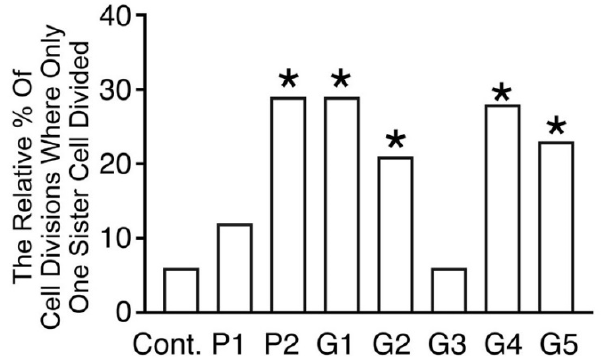
Figure 4. Histograms showing the relative percentage of sister cells where there was unpaired cell division. Unpaired sister cell division was comparatively uncommon in the control medium, but increased relative to the control in almost all bracket-conditioned media (* p < 0.05, Binomial